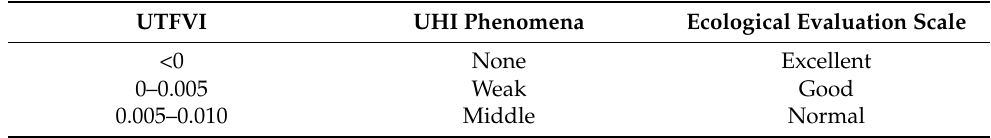
Table 1. Association between UTFVI, UHI phenomena, and their correspondent ecological